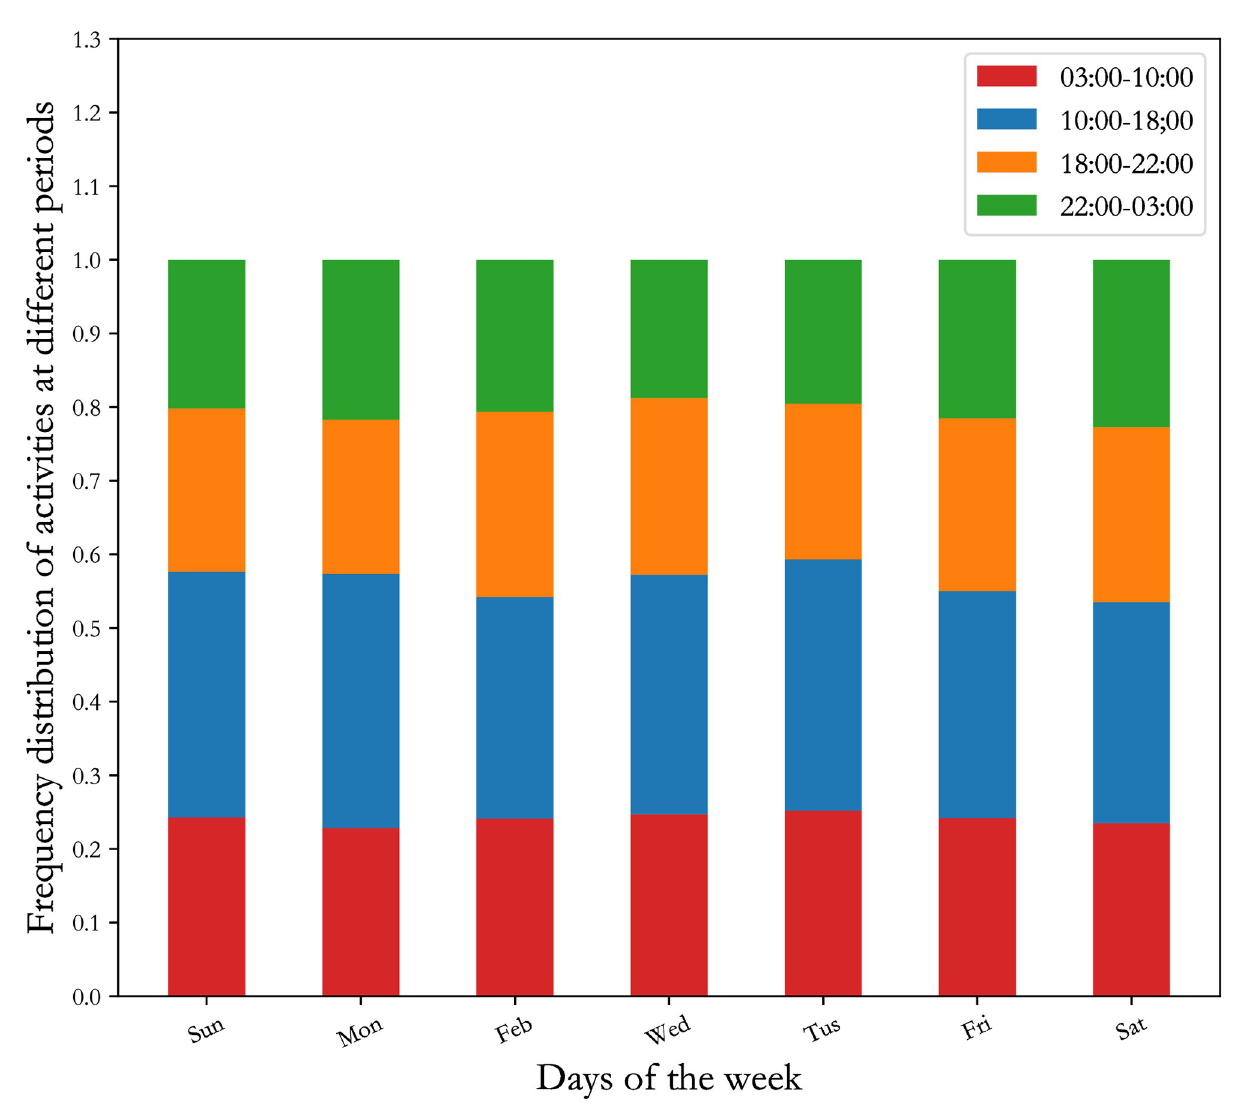
Fig 4. The frequency distribution of users’ activities at different time periods in days of the